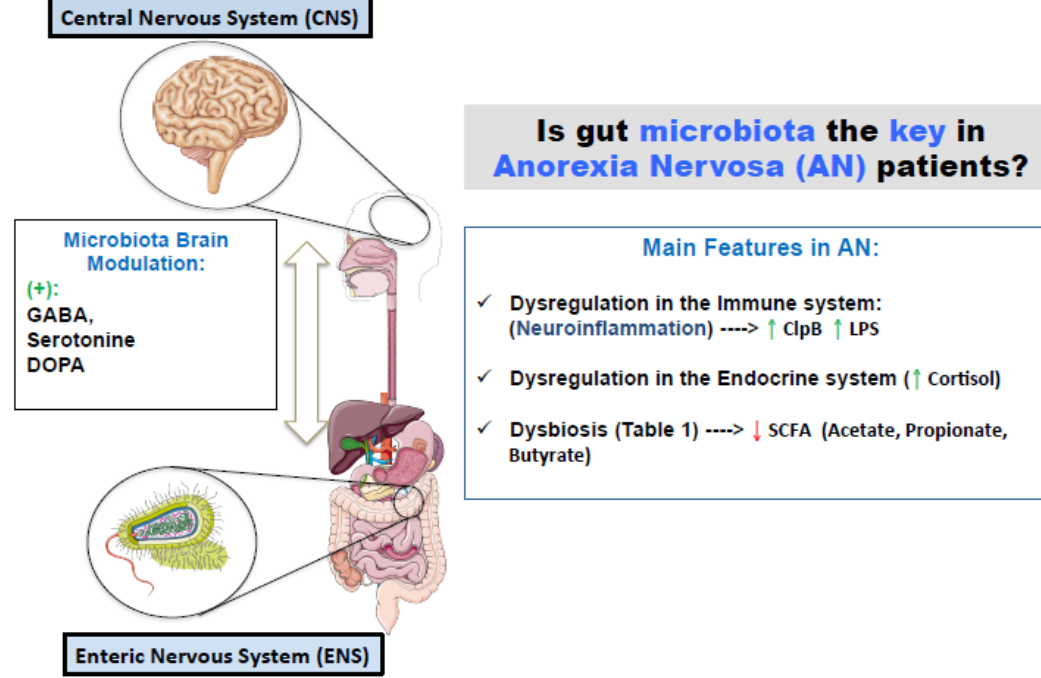
Figure 1. Microbiota as a recruiter of bidirectional communication between the brain and the gut and changes in microbiota composition observed in Anorexia Nervosa patients [15,17,19].